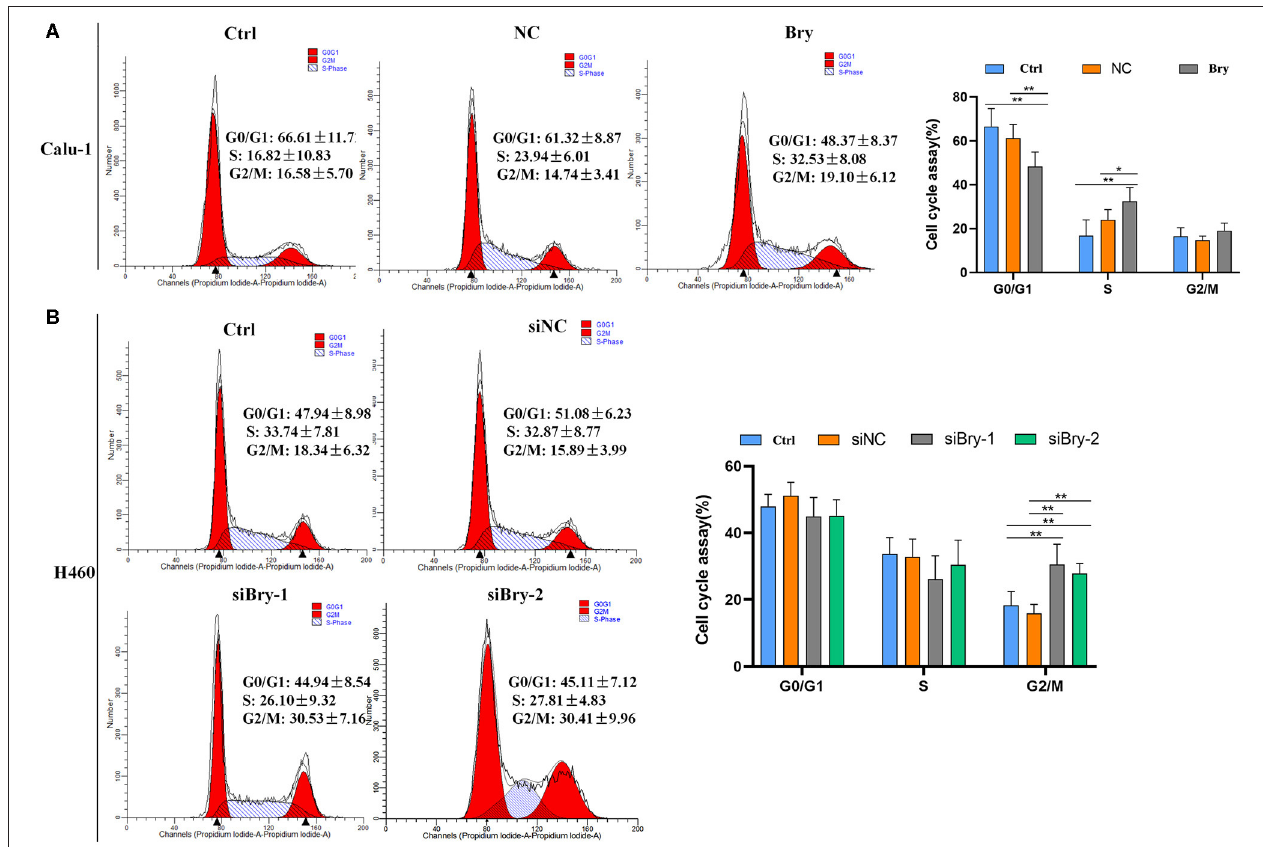
FIGURE 3 | The effect of Bry on cell cycle. (A) Cell cycle analysis of Bry-overexpression Calu-1 cells. Overexpression of brachyury in Calu-1 cells could promote the transition from G0/G1 to S phase. (B) Cell cycle analysis of Bry-knockdown H460 cells. Inhibition of brachyury expression in H460 cells could increase the percentage of G2/M phase (* P < 0.05, ** P <